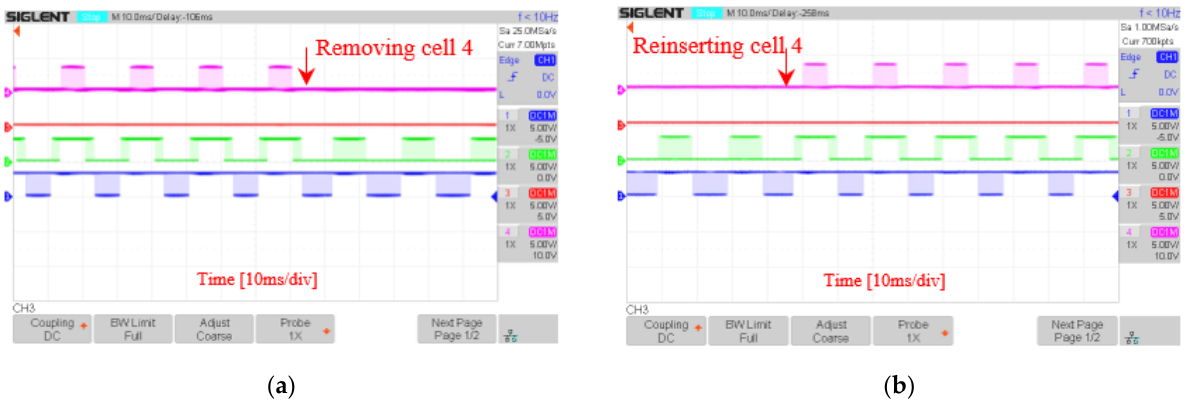
Figure 42. Control signal of IGBT when removing and reinserting cell 4 by using DSA-LSC method, ( a ) PWM control signals; ( b ) PWM control signals.